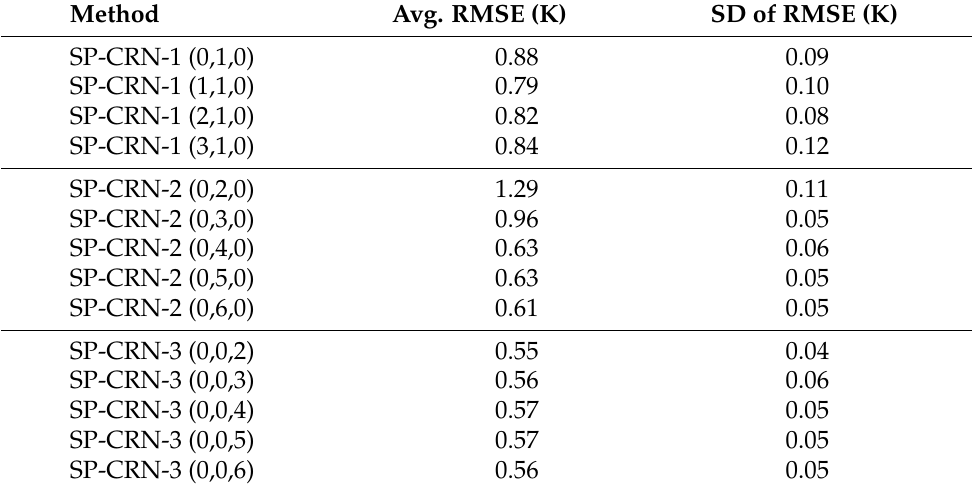
Table 3. Evaluation of different settings on SST predictions for SP-CRN with three proposals. The highlighted result in blue shows the best prediction accuracy for each proposal, while the highlight in gray is the SP-CRN baseline result.